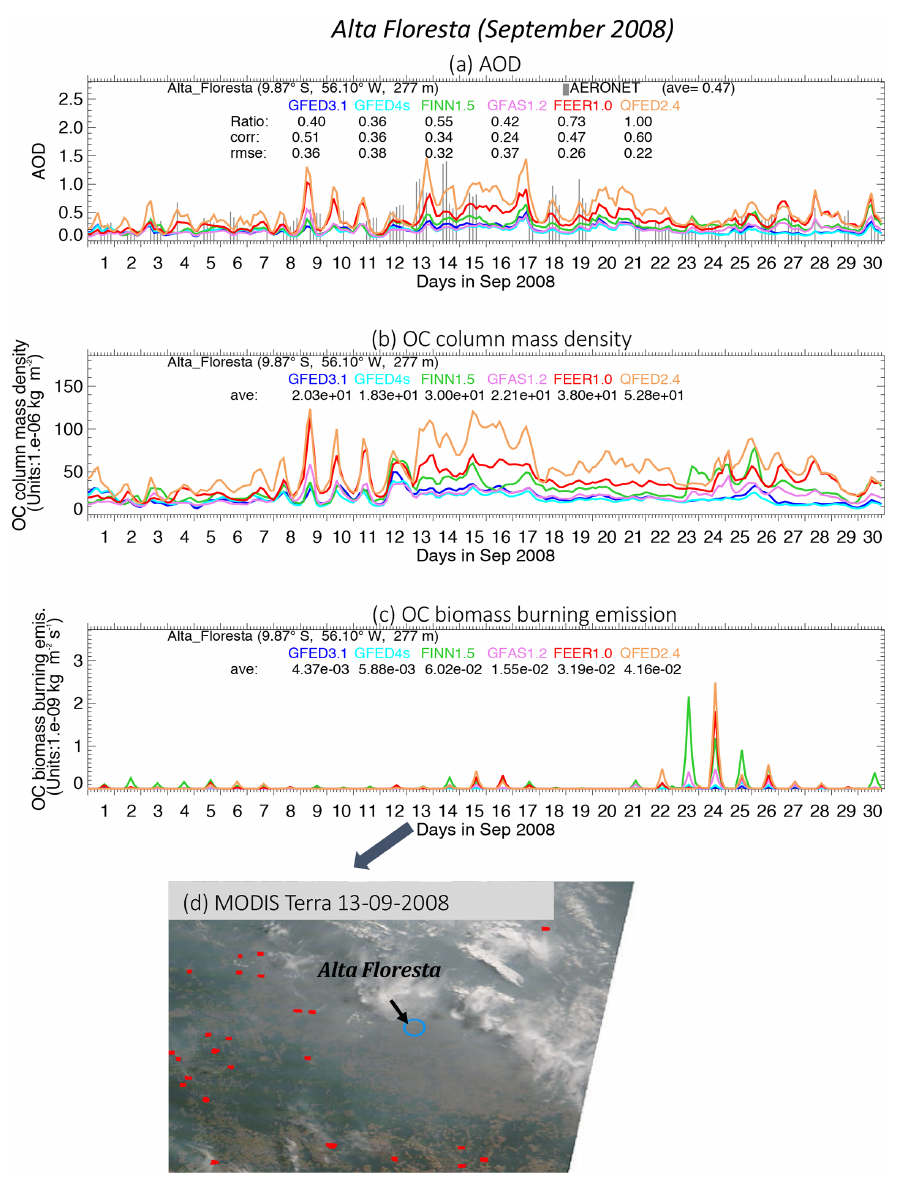
Figure 8. Characteristics of the observed and the simulated aerosols at Alta Floresta during September 2008: (a) the 3-hourly time series of AOD at 550nm. The AERONET AOD is represented by vertical gray bars, and the outputs from the six model experiments are represented by the color curves. The relevant statistics are listed: ave is the monthly average, ratio is the fraction of the simulated to the observed AOD at all observed hours, corr is correlation coefficient between the observed and the simulated AOD, and RMSE is root-mean-square error. (b) The 3-hourly time series of OC column mass density over the grid box where Alta Floresta is located (units: 1 × 10 − 6 kgm − 2 or mgm − 2 ). (c) Same as panel (b) but for biomass burning OC emission rate (units: 1 × 10 − 9 kgm − 2 s − 1 or µgm − 2 s − 1 ). (d) MODIS Terra true-color image around Alta Floresta on 13 September 2008, overlaid with the active fire detections as red dots (image credit: https: //aeronet.gsfc.nasa.gov/cgi-bin/bamgomas_interactive, last access: 29 December 2018, and https://worldview.earthdata.nasa.gov, last access: 29 December